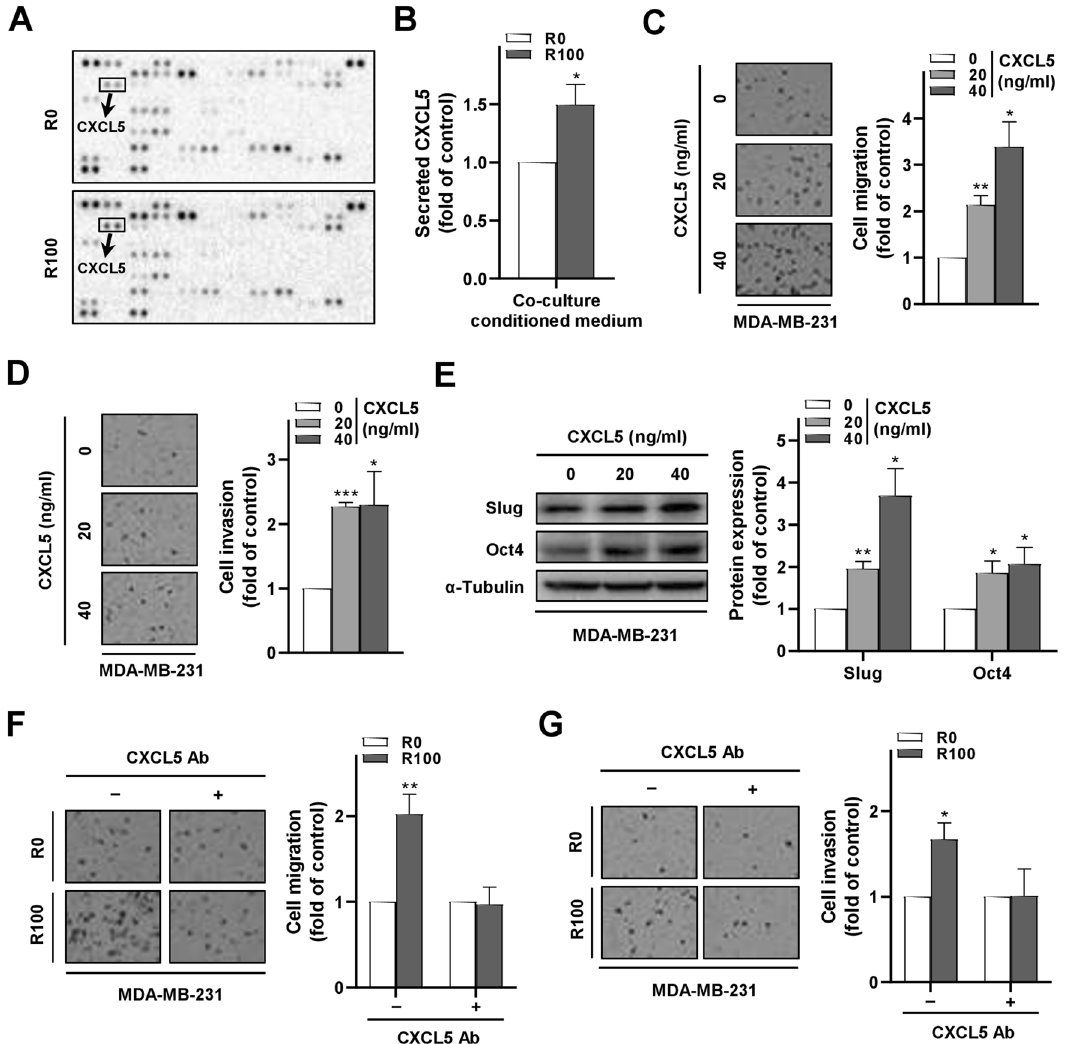
Figure 3. Secreted CXCL5 in the conditioned medium of the co-culture model with resistin-stimulated ADSCs promoted malignant behaviors of breast cancer cells. The isolated ADSCs were treated with resistin at 0 and 100 ng/ml (R0 and R100, respectively) for 48 h, followed by co-culture with MDA-MB-231 cells in the transwell model for another 72 h before the analyses in (A,B,F,G). ( A ) The conditioned medium from the co-culture of R-ADSCs (R100) or control ADSCs (R0) with MDA-MB-231 cells was collected and analyzed by cytokine/ chemokine proteome array. A total of 102 proteins were detected with duplicates for each protein. The position of CXCL5 on the array was highlighted. ( B ) Secreted protein level of CXCL5 in the conditioned medium from the co-culture of R-ADSCs (R100) or control ADSCs (R0) with MDA-MB-231 cells was analyzed by ELISA. ( C ) MDA-MB-231 cells treated with recombinant CXCL5 (0, 20, and 40 ng/ml) for 48 h were collected and evaluated by cell migration assay. ( D ) MDA-MB-231 cells treated with recombinant CXCL5 (0, 20, and 40 ng/ml) for 48 h were collected and evaluated by cell invasion assay. ( E ) MDA-MB-231 cells treated with recombinant CXCL5 (0, 20, and 40 ng/ml) for 48 h were collected and analyzed for the protein expression of mesenchymal marker Slug and cancer stemness marker Oct4 by Western blot. The original blot images in (A) and (E) were available in Supplementary Information. ( F,G ) CXCL5 neutralizing antibody was added ( +) or omitted (–) during the co-culture of R-ADSCs (R100) or control ADSCs (R0) with MDA-MB-231 cells. After the co-culture, MDA-MB-231 cells were collected and evaluated by cell migration assay in (F) and cell invasion assay in (G). Data were obtained from three independent experiments and presented as mean ± SEM. Statistical difference was determined by t-test comparing R100 group versus their corresponding R0 group as control, or comparing recombinant CXCL5 treatment group (20 and 40 ng/ml) versus recombinant CXCL5 control group (0 ng/ml). * p < 0.05; ** p < 0.01; *** p <